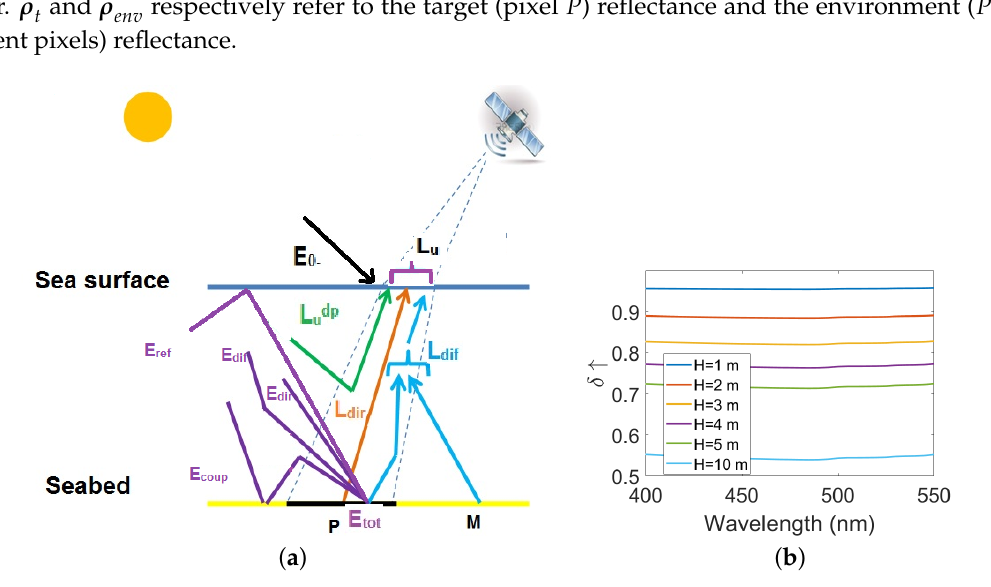
Figure 1. ( a ) Various components of the light that contributes to the sub-surface radiance (from [45]). The reader is referred to Table 1 for the definition of the notations used in the Figure. ( b ) Environment vector δ ↑ , which represents the weight of the target pixel contributing to the diffuse radiance, for a target radius of 0.5 m, for various seabed depths ranging from 1 m to 10 m, and moderately turbid water conditions, corresponding to a chlorophyll-a concentration Chl = 1 mg m − 3 , a suspended matter concentration SM = 1 mg L − 1 , and a color dissolved organic matter concentration CDOM = 0.1 m − 1